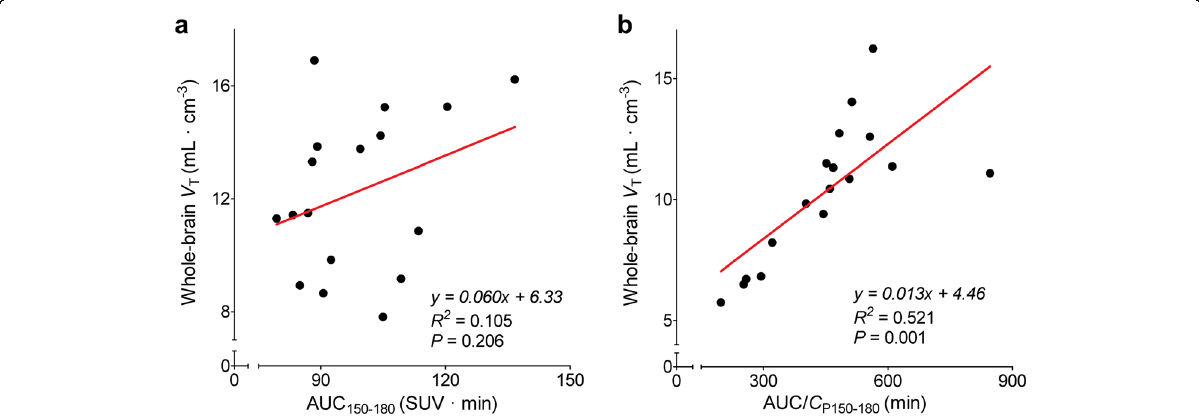
Fig. 6 Correlation of the “ gold-standard ” measurement of whole-brain total distribution volume ( V T ) and two more simplified values. a Area under the brain time-activity curves measured from 150 to 180 min (AUC 150 – 180 ). b The same value normalized (i.e., divided) by the mean concentration of parent radioligand in arterial plasma measured at 150 and 180 min (AUC/ C P150 – 180 ). The points represent individual values from 17 healthy volunteers. The line represents a linear fit of the